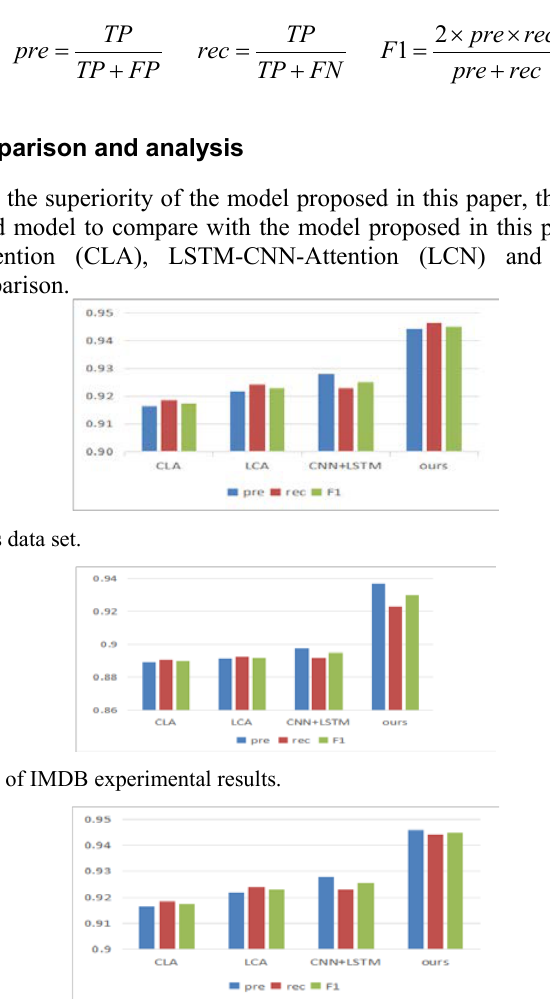
Fig. 7. Comparison of experimental results of Chinese data sets in Fudan